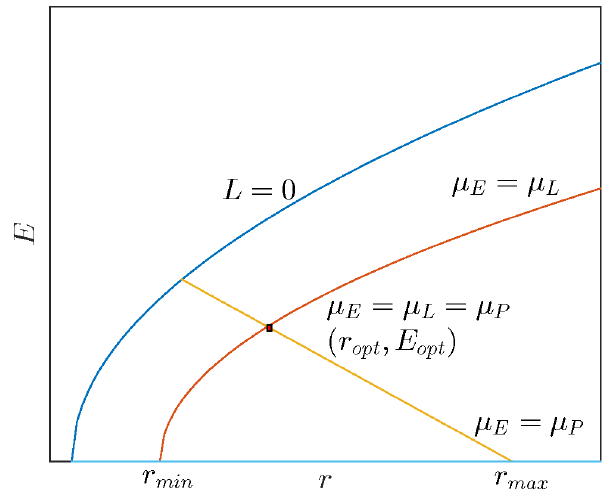
Figure 4. Diagram of strategy space. The (r,E) plane is divided into a region in the first quadrant where L > 0 corresponds to the set of allowable strategies. The optimal strategy occurs at the point (cid:0) r (cid:1) , denoted by the red rectangle, where µ = µ opt ,E opt µ E